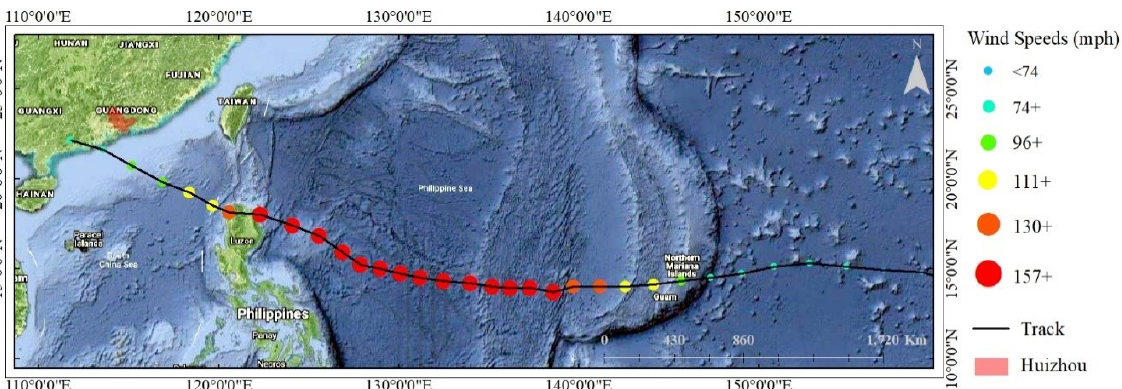
Figure 10. The track of super typhoon Mangkhut over the western North Pacific and the South China Sea. The six categories of wind speeds are represented by the different colored dots. The track map was made using the ArcGIS 10.5 software based on the satellite base map layer, which was obtained from © Google Maps (map data © 2019 Google).